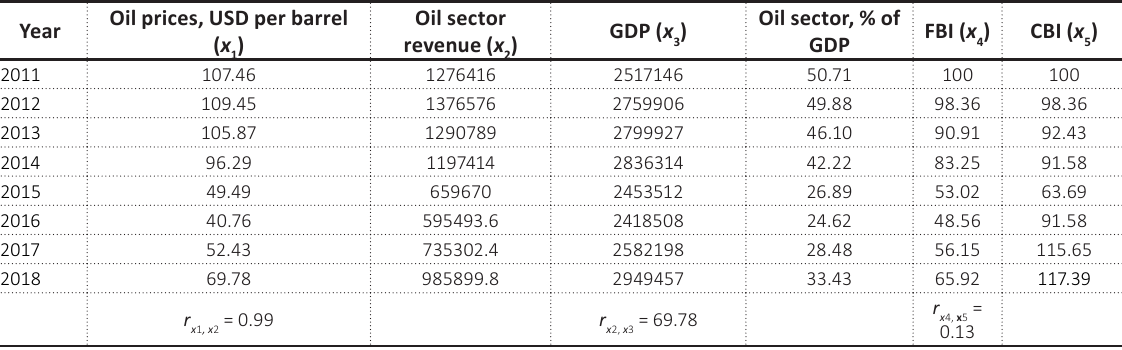
Table 4. Contribution of the oil sector to GDP and its sensitivity and trend (SR million)